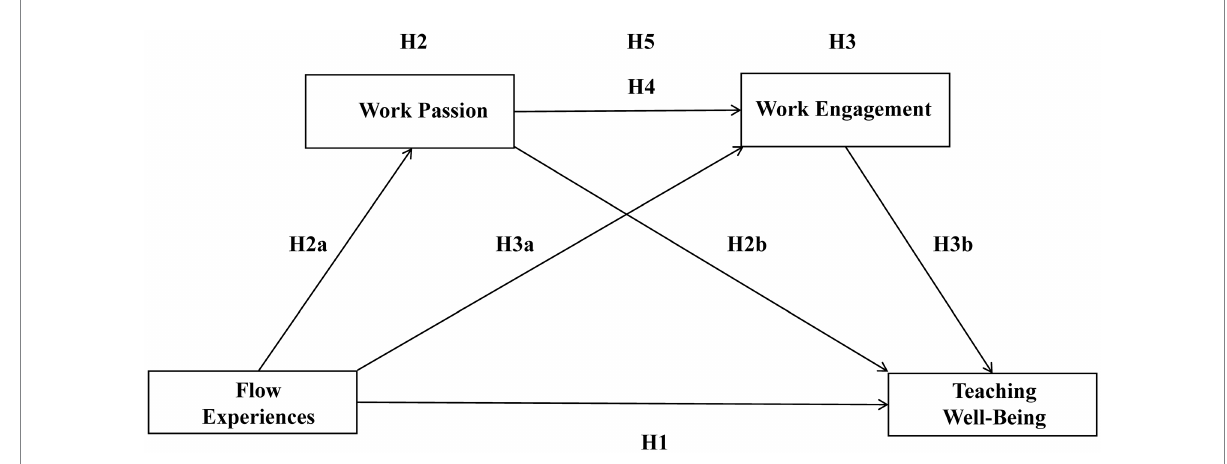
FIGURE 1 The conceptual model and research hypotheses of this